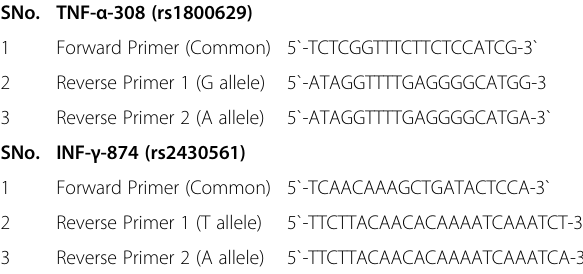
Table 2 Primer sequences used for TNF- α A/G and INF- γ T/A genotypes and allelic polymorphisms in skin biopsies of leishmaniasis